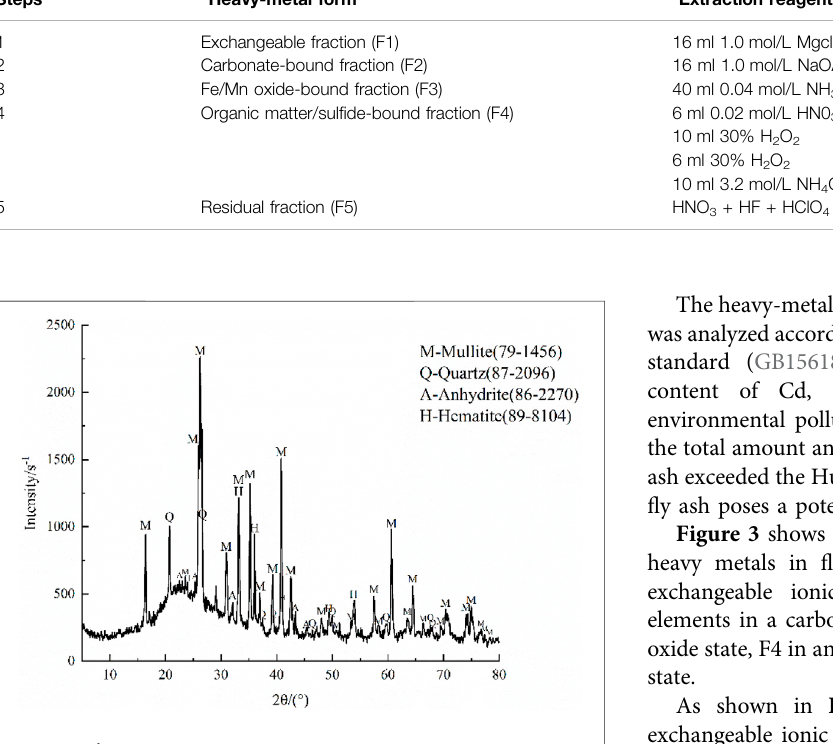
FIGURE 2 | XRD atlas of fl y ash.